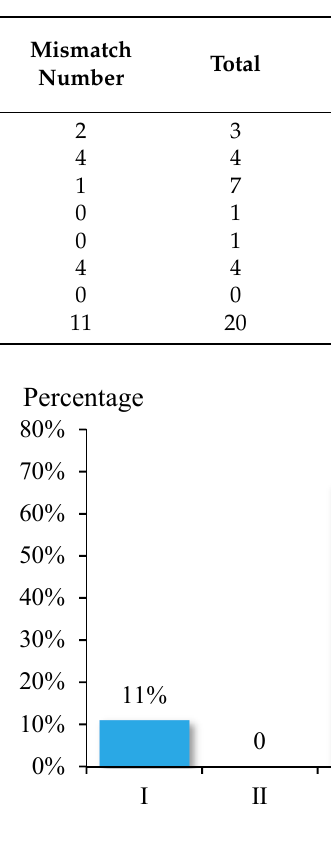
Table 7. Matching results of the rainfall patterns identified by two kinds of data.